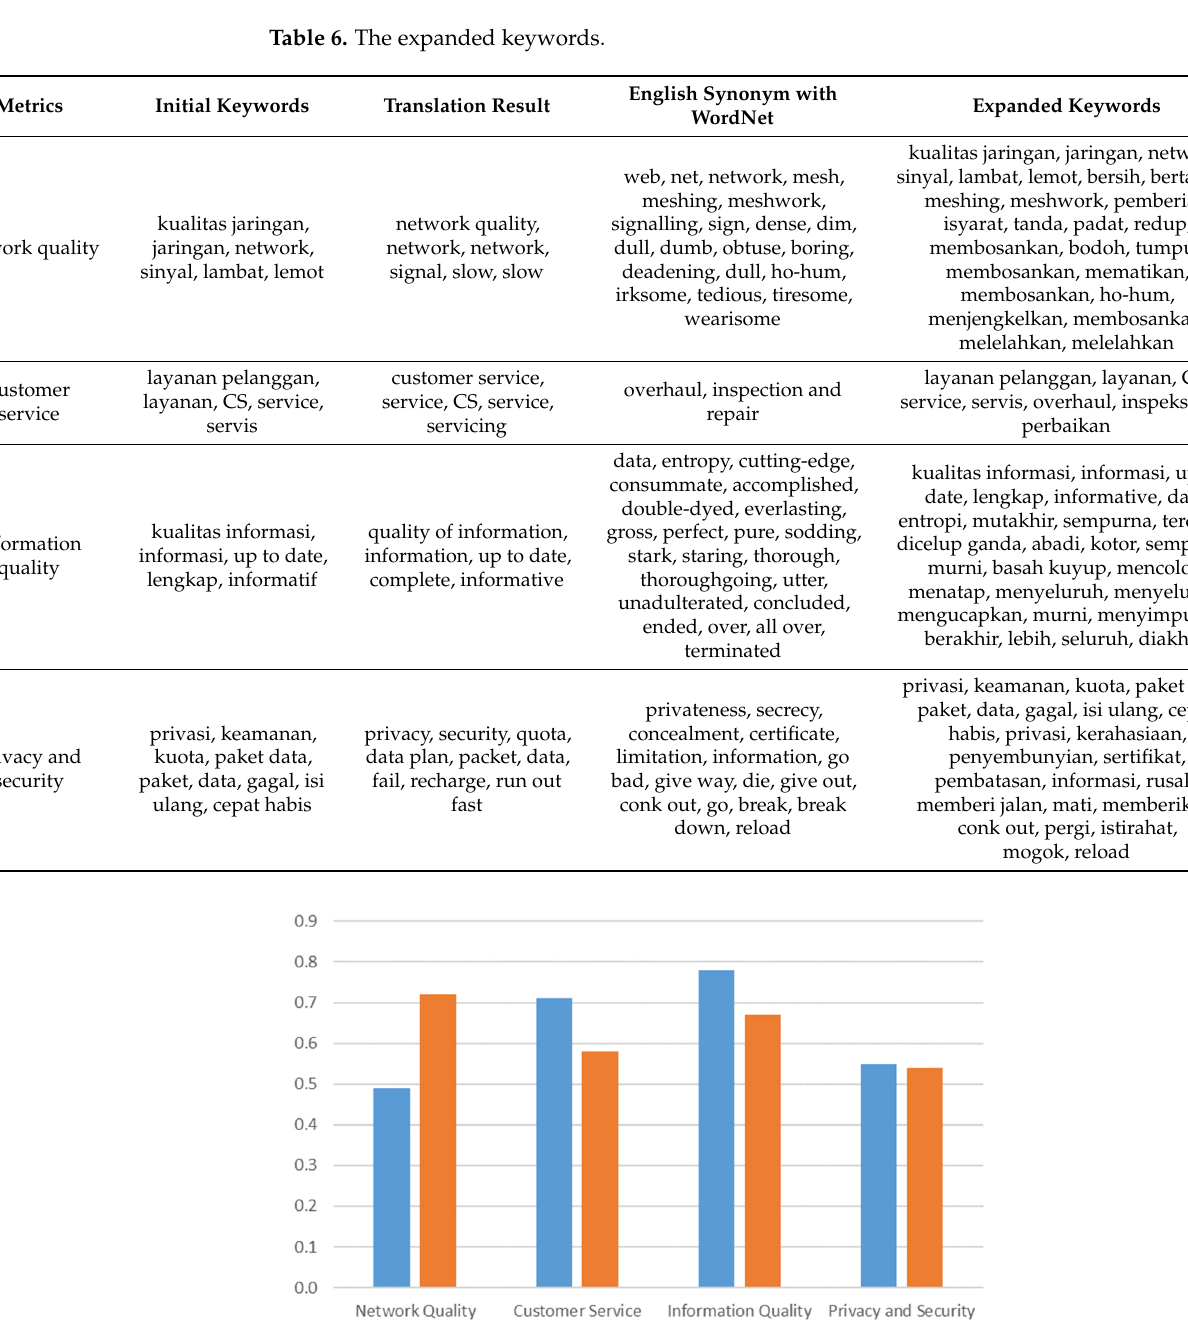
Figure 7. Comparison of service quality rate between By.U and MPWR.